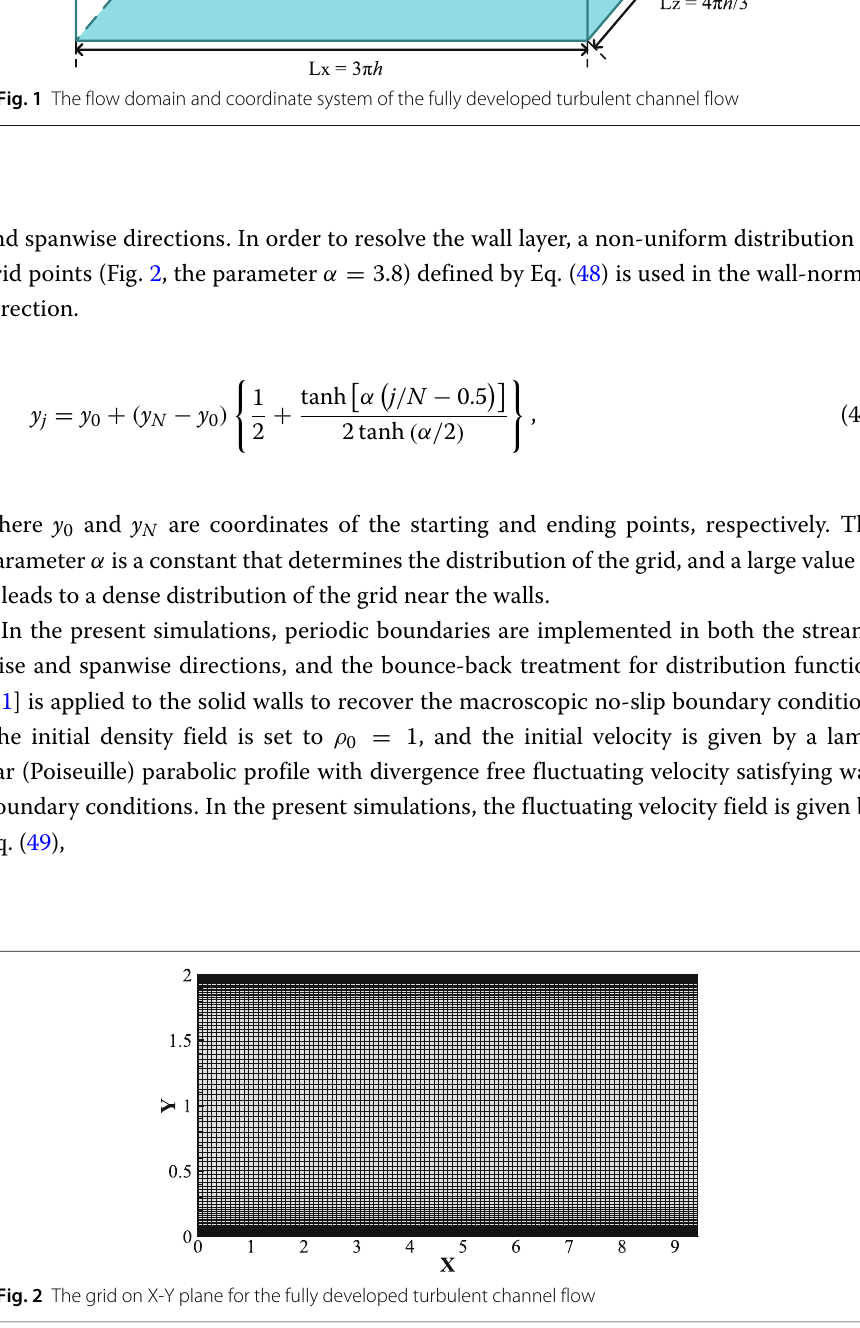
Fig. 1 The flow domain and coordinate system of the fully developed turbulent channel flow